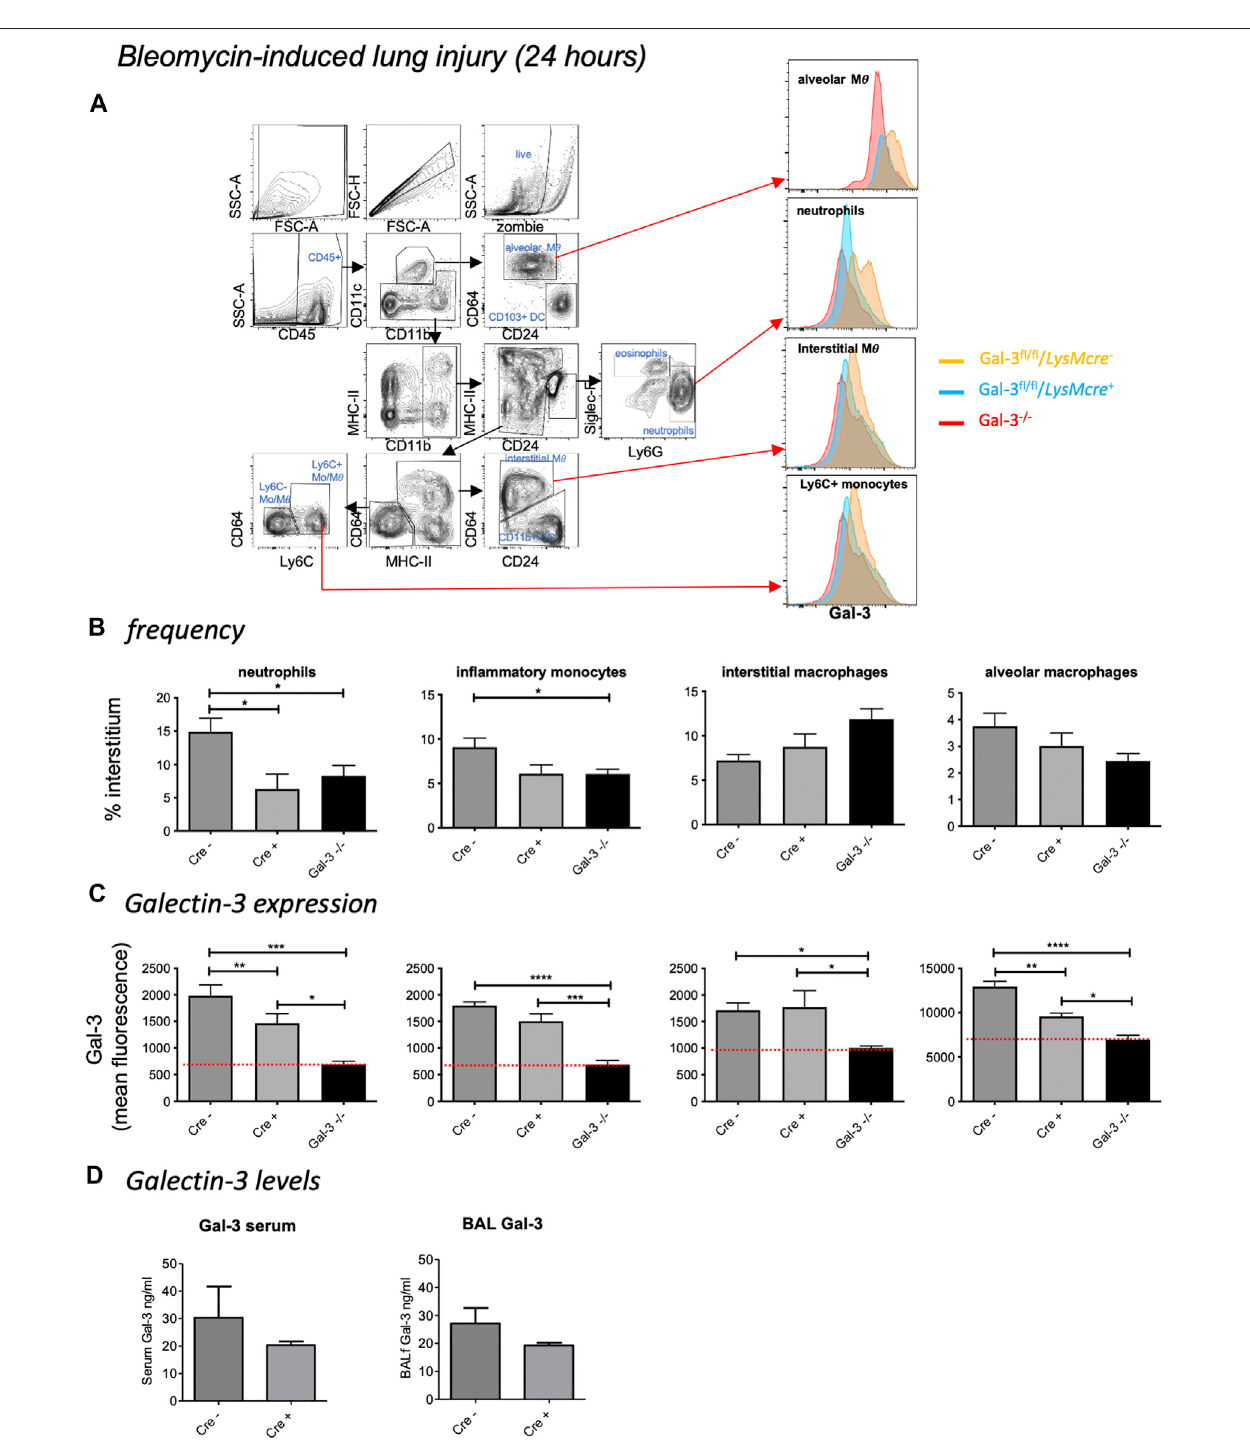
FIGURE2| Bleomycin-inducedacutelunginjury.Micereceived33 µgbleomycinandwereretrievedat24 h. (A) Flowcytometricgatingstrategytoidentifyimmune cell subsets and Gal-3 expression within the lung. After gating for single, live cells, leukocytes were selected based on CD45 expression. Alveolar macrophages (M Φ ) (SiglecF + CD11b int CD11c + CD64 + ),CD103 + dendriticcells(DCs -CD11c + CD103 + CD24 + ),neutrophils(CD11b + Ly-6G + ) and eosinophils (SiglecF + CD11b + CD11c – ), followedbyidenti fi cationofthepopulationswithoverlappingexpressionpatterns:interstitialmacrophages(CD11b + MHCII + CD11c + CD64 + CD24 – ),CD11b + DCs (CD11b + MHC II + CD11c + CD24 + CD64 – ), in fl ammatory monocytes (CD11b + MHC II − CD64 − Ly-6C hi ) and patrolling monocytes (CD11b + MHC II − CD64 − Ly-6C low ). (B) Interstitialleukocytefrequenciesfollowingacutebleomycin. (C) Galectin-3expressioninleukocytesubsets.Redlinerepresentsmean fl uorescenceintensity(MFI)in Gal- 3 − / − mice. d) Gal-3 levels in serum and BAL. Data represented as mean ± SEM. Analysed via 1-way ANOVA (b,c) or students t -test. (D) ( n (cid:1) 6, * p < 0.05, ** p < 0.01, *** p < 0.001).